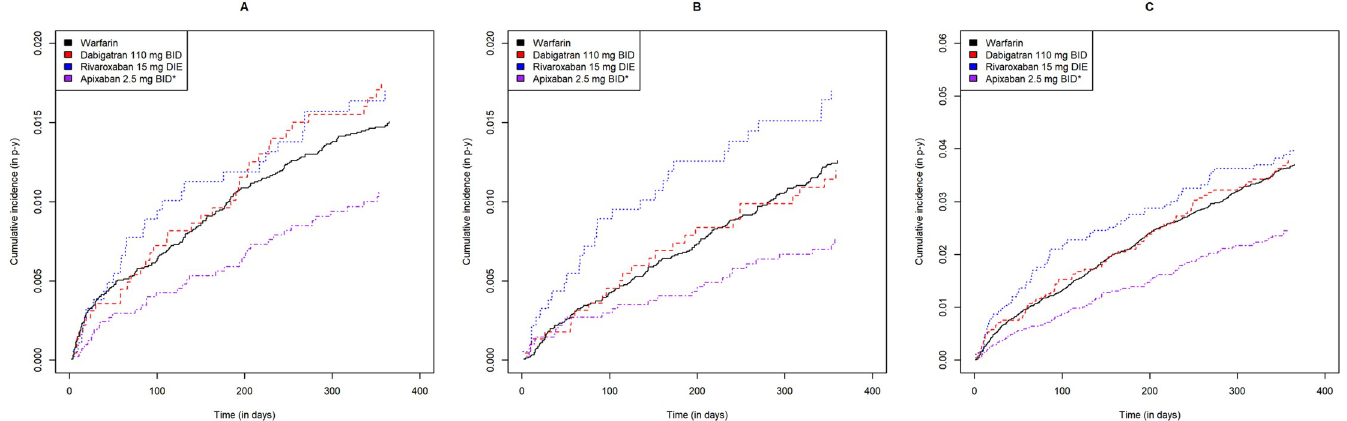
Fig 2. Gastrointestinal, non-gastrointestinal extracranial and all major bleeding cumulative incidence curves for each direct oral anticoagulant at low dose relative to warfarin. Warfarin, dabigatran, rivaroxaban and apixaban are shown in black, red, blue and purple, respectively. Gastrointestinal, non-gastrointestinal and all major bleeding are shown from left to right. � statistically significant difference relative to warfarin (p < 0.05).